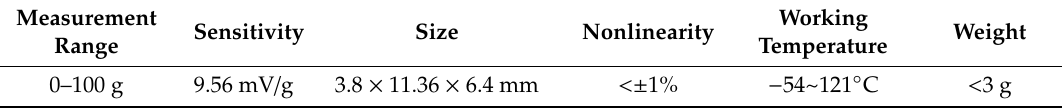
Table 1. Main parameters of the Integral Electronic Piezoelectric (IEPE) accelerometer.